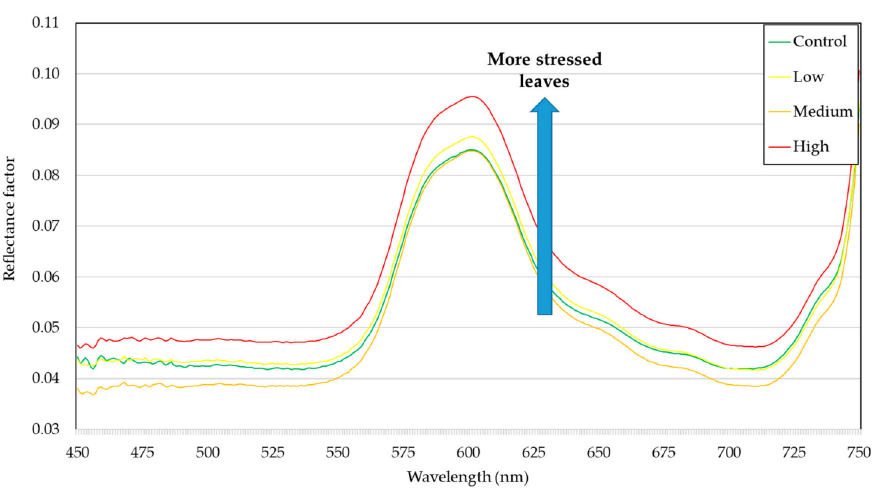
Figure 4. Average spectral curves (450–750 nm) of soybean leaves under different levels of whitefly